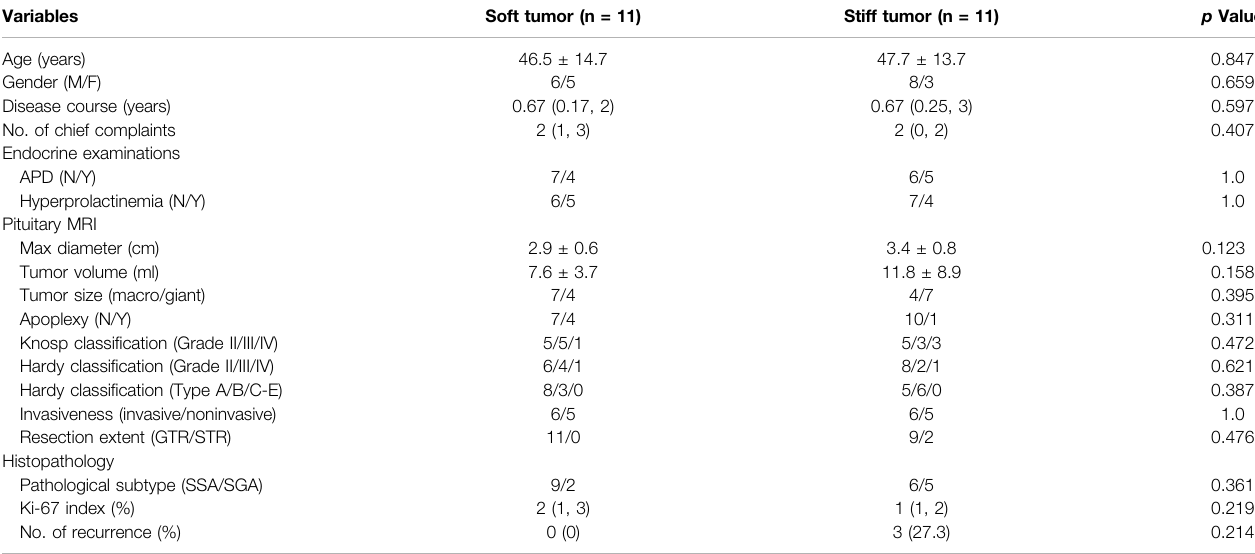
TABLE 1 | Demographics and clinicopathological features of 22 patients diagnosed with pituitary adenomas.